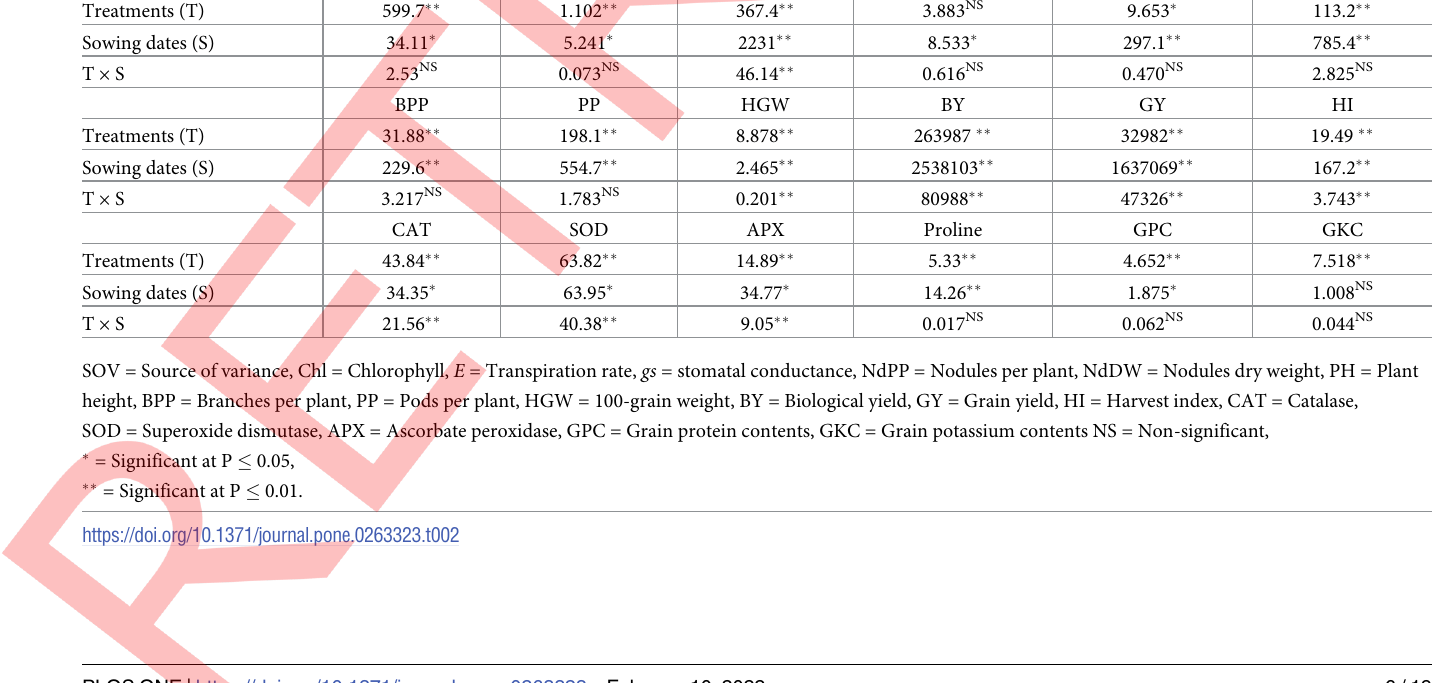
Table 2. Mean sum of squares of growth, physiological and yield parameters in response to foliar applied K and MLE in normal and late sown kabuli chickpea. SOV